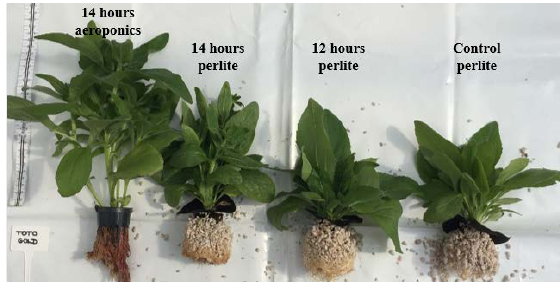
Figure 2. 11 weeks-old Rudbeckia hirta ’Toto Gold’ plantlets depending on photoperiodic lighting treatments and media (University of Debrecen, Biological Research and Plant Experiment Greenhouse - Biodrome, Debrecen, Hungary, 2021).